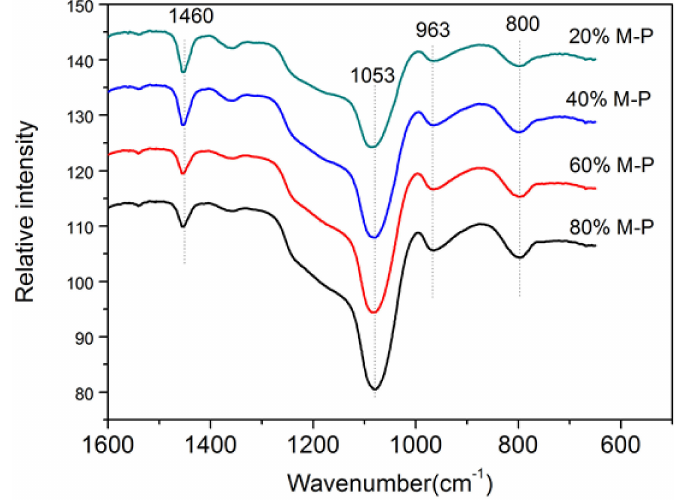
Figure 6. FT-IR spectra of the honeycomb